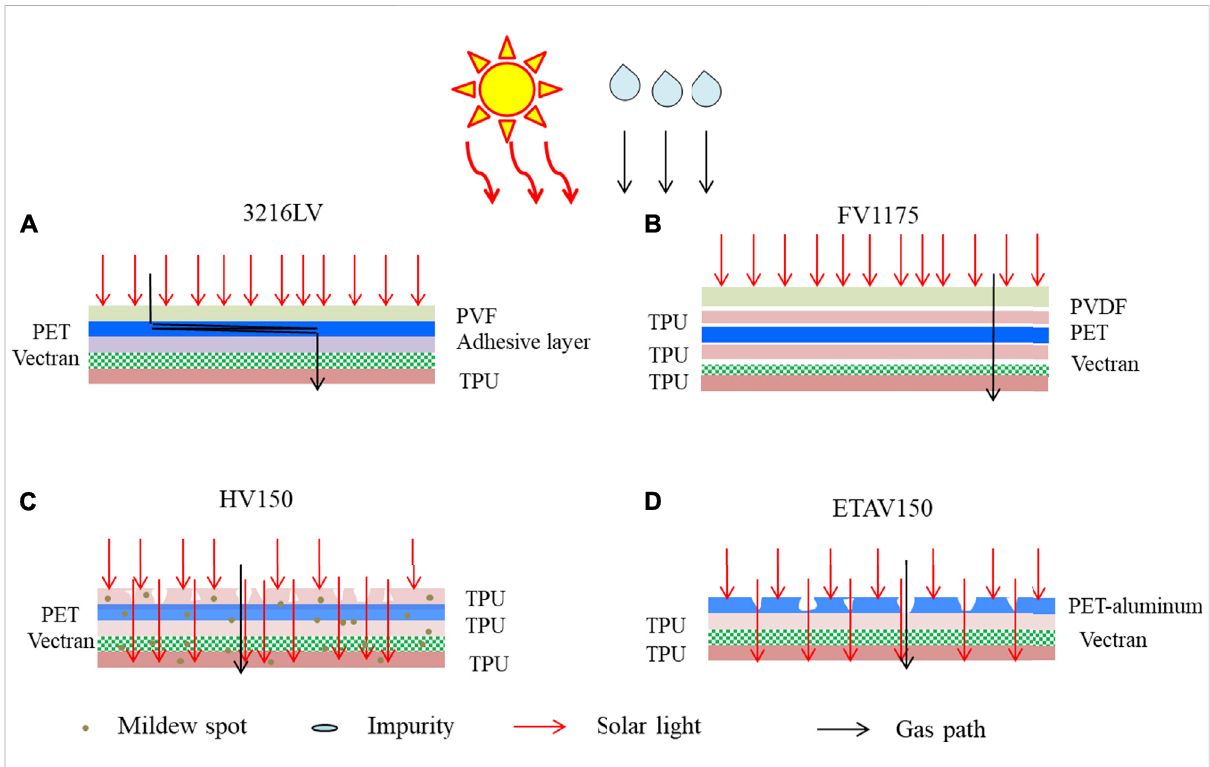
FIGURE 9 Simpli fi ed schematic illustration of natural aging mechanism of (A) 3216LV, (B) FV1175, (C) HV150 and (D) ETAV150 in